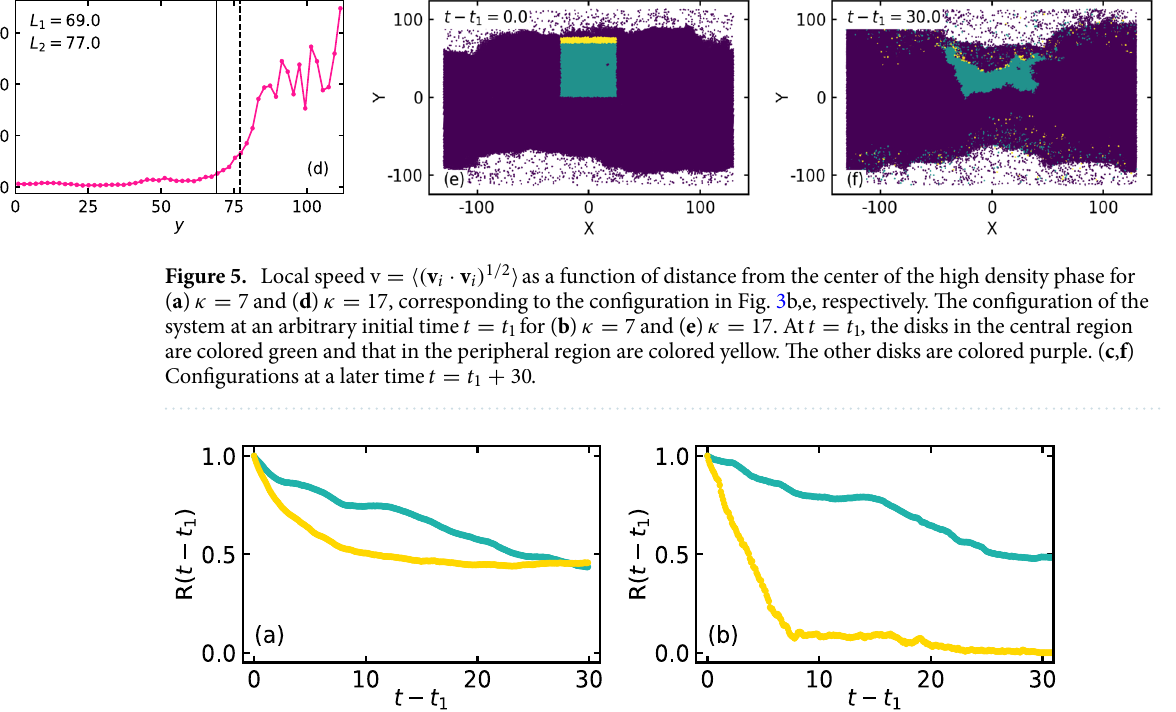
Figure 6. Retention fraction R ( t peripheral (yellow) region of the high density phase for ( a ) κ are same as in Fig.